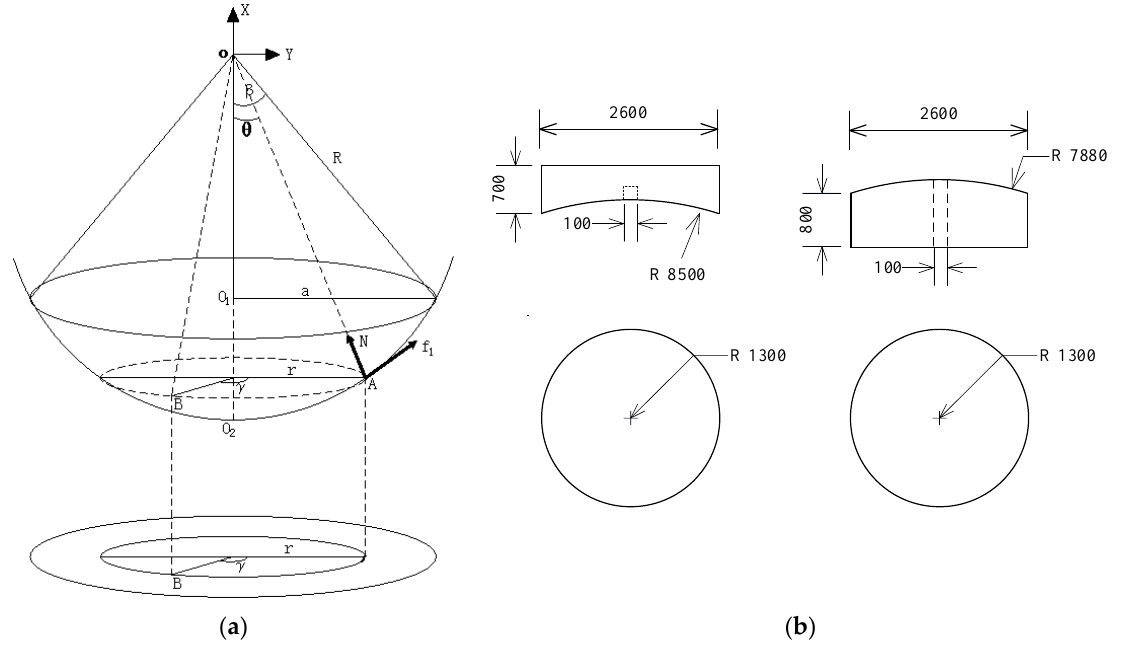
of the spherical joint. the spherical joint.